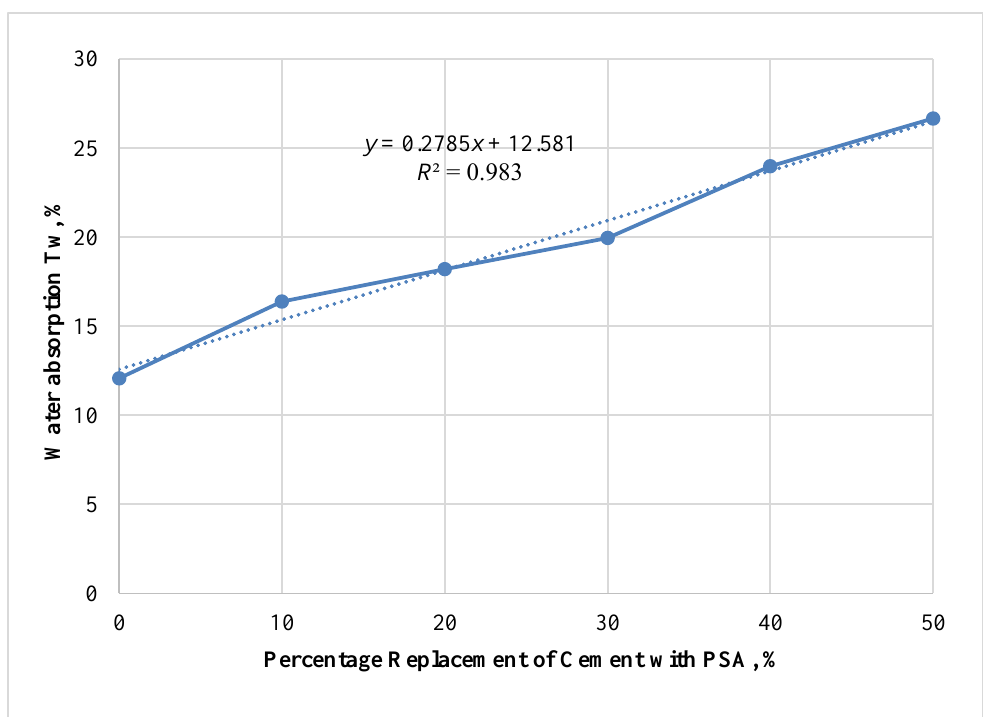
y = 0.2785 x + 12.581 R ² =